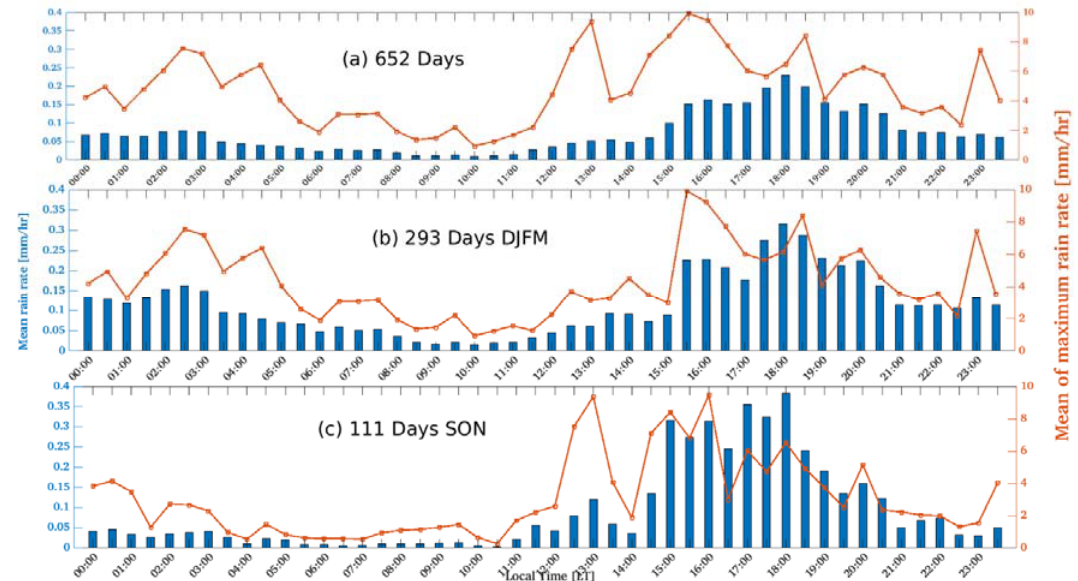
Figure 4. Time series of the mean rain rate (mm/h, in Blue) and mean of the maximum rain rate (mm/h, in Red) for ( a ) 01/12/2015–31/12/2018, ( b ) December to March months (2015–2018) and ( c ) September to March months (2015–2018) observed from MIRA35c.